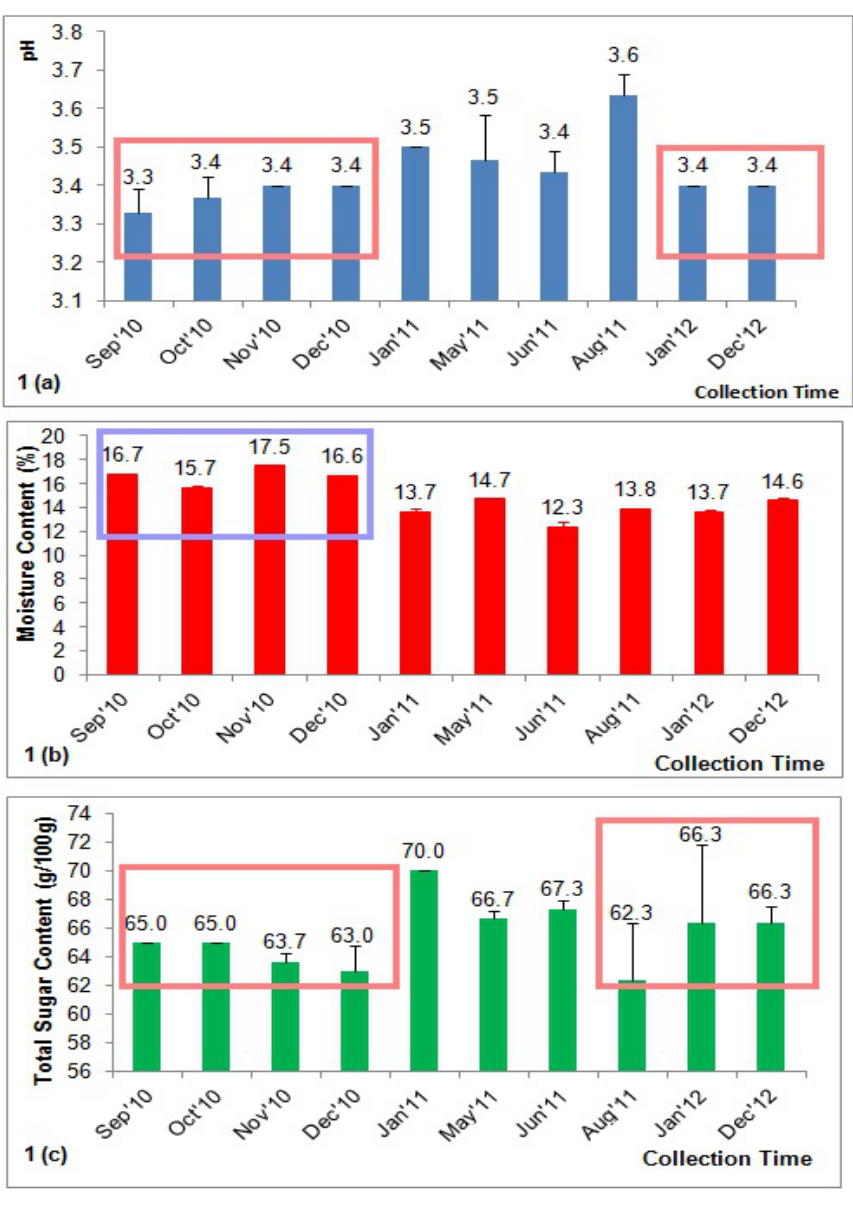
Figure 1. Variations in the ( a ) honey pH, ( b ) moisture content and ( c ) total sugar content in the investigated honey